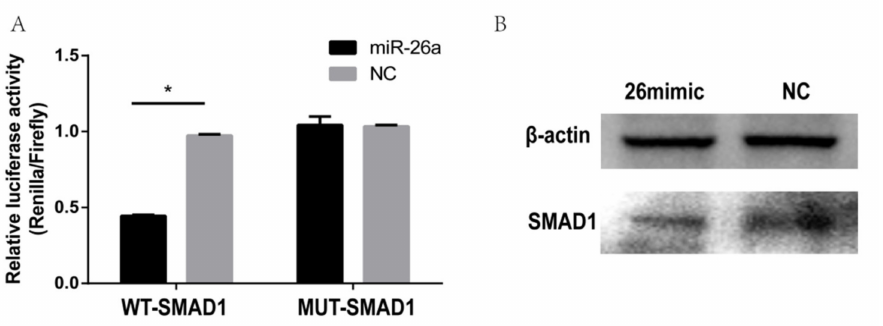
Figure 10. Verification results of the dual-luciferase reporter system of miR-26a and the target gene SMAD1 . ( A ) Expression of relative luciferase activity in wild type vector (WT group) and mutant (MUT group). The marker * represents a significant di ff erence between the experimental group and the control group ( p < 0.05). ( B ) Western blot analysis of SMAD1 after a transfection with the miR-26 mimic, negative control